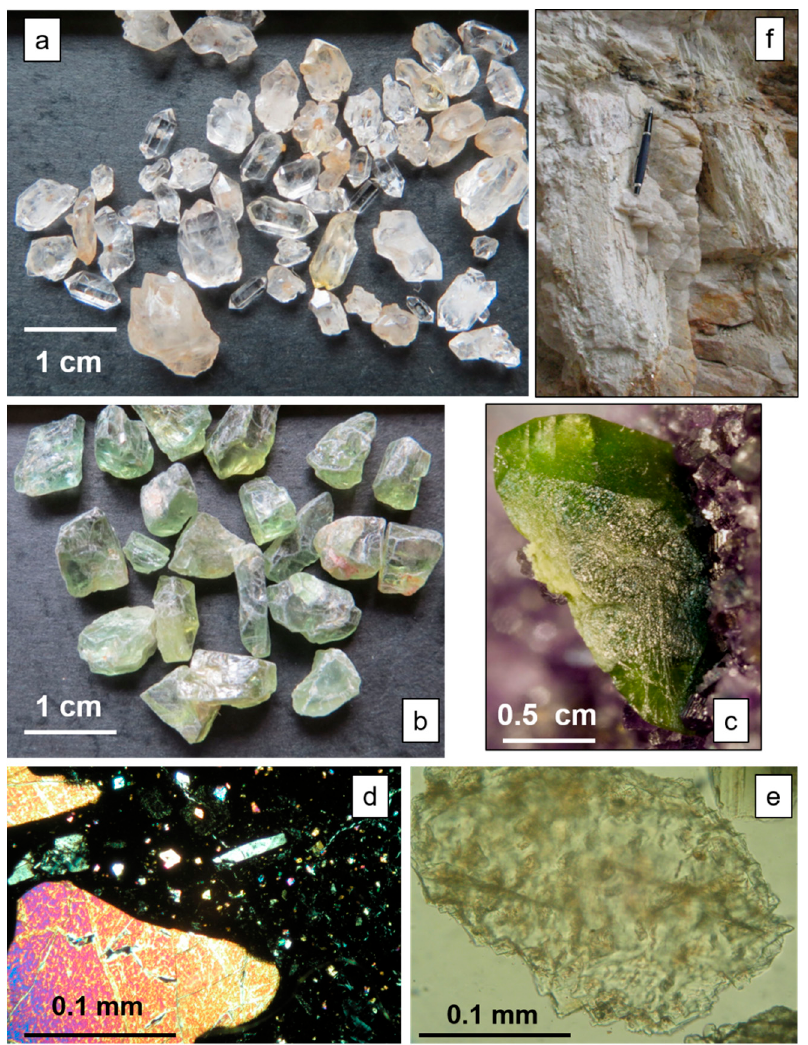
Figure 16. Silicates of rare occurrence in placer deposits. ( a ) “Rock crystals” of double-terminated quartz washed out from placer deposits, Madagascar. ( b ) Panned diopside crystals from placer deposits, Madagascar. ( c ) Chromium-bearing titanite from the Ural Mts., Russia (rotated for display by 90°). ( d ) Micrograph of subrounded phenocrysts of olivine besides angular microphenocrysts of plagioclase floating in a basanitic host rock, Mongolia (crossed polars). ( e ) Olivine strongly corroded during transport and weathering in a fluvial placer deposit of a tributary stream proximal to the basanitic host rock—see Figure 16c, Mongolia (panned heavy mineral concentrate, plane polarized light). ( f ) Green spodumene gradually alters to cookeite at the edge of a pegmatite in Minas Gerais, Brazil. See biro for scale.